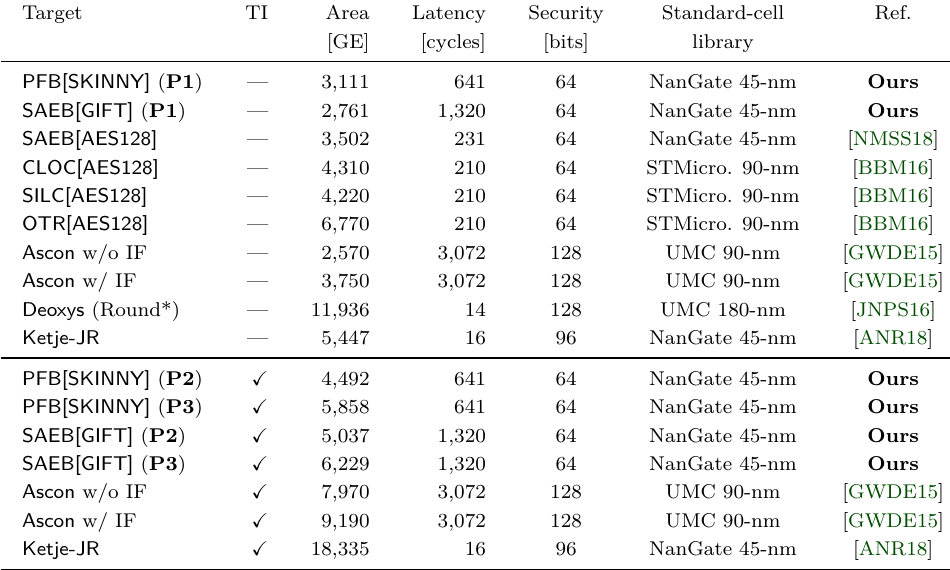
Table 4: Performance comparison; latency is that of a single call of a primitive (block cipher, tweakable block cipher, or